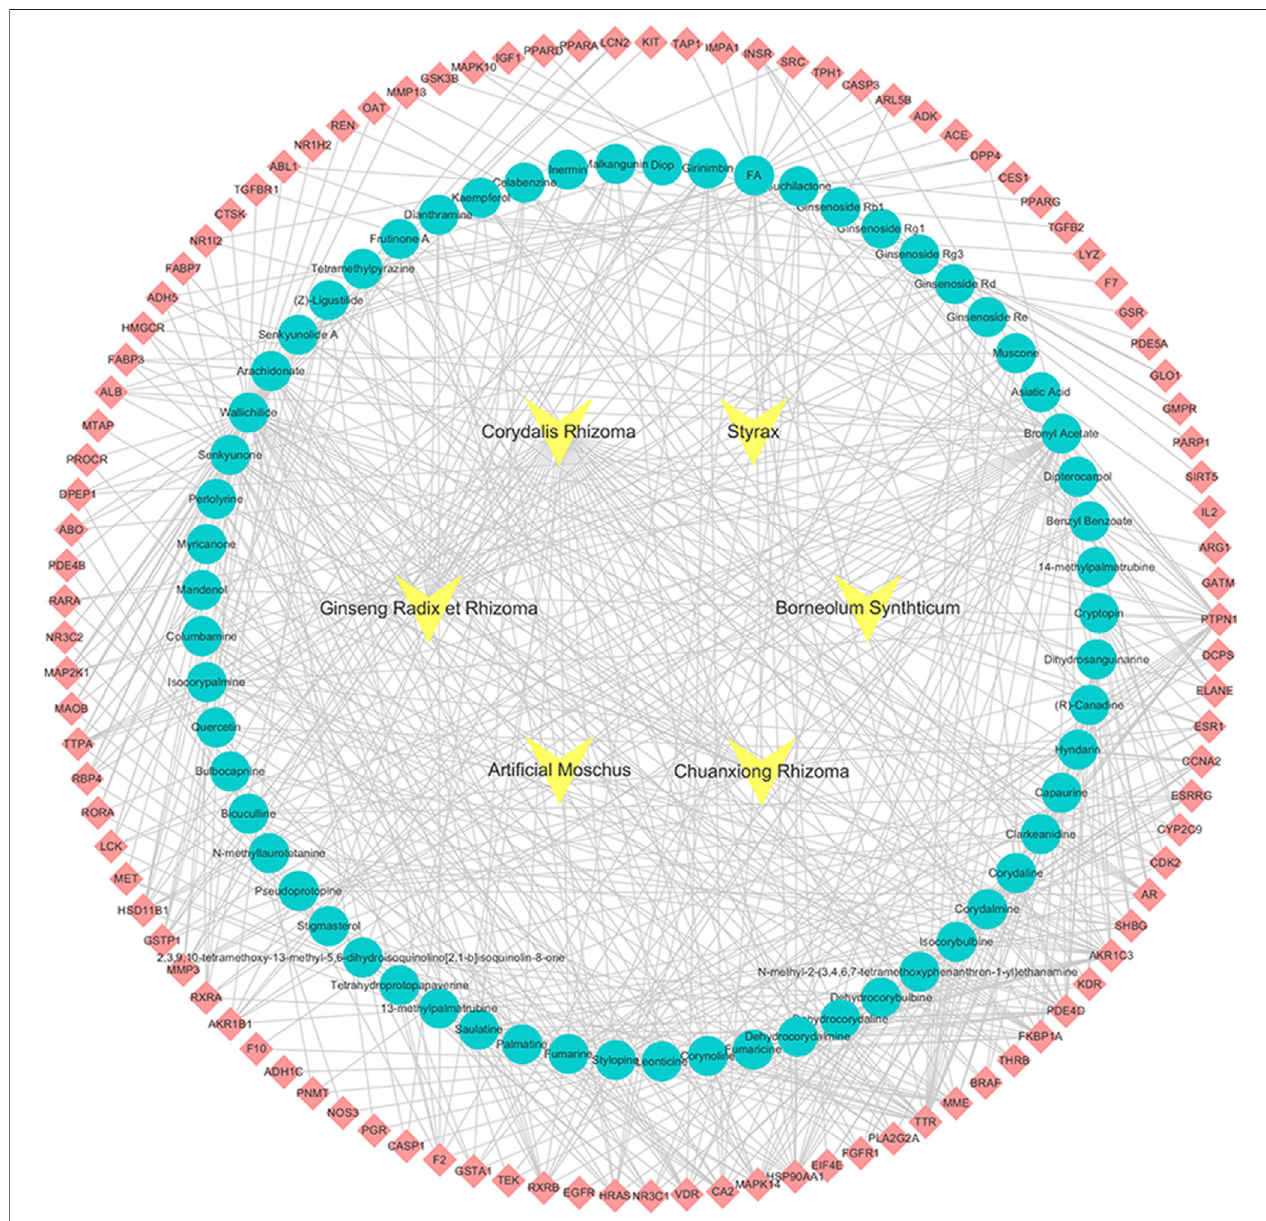
FIGURE 1 | Drug-components-targets network of six herbs in XTN predicted to have 104 candidate targets, the yellow nodes represent the six herbs, the blue nodes represent chemical components and the red are candidate targets.